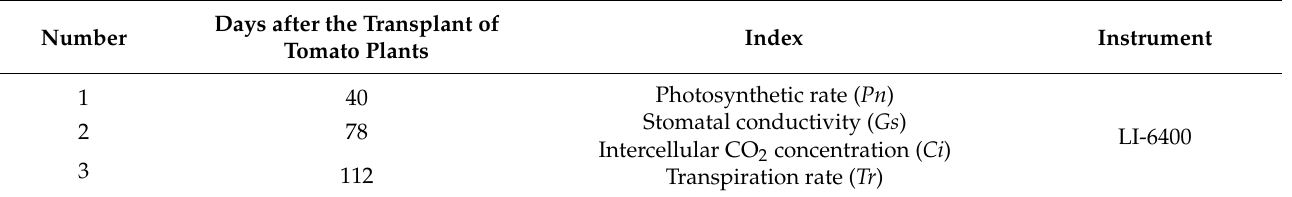
Table 2. Photosynthesis measurements.